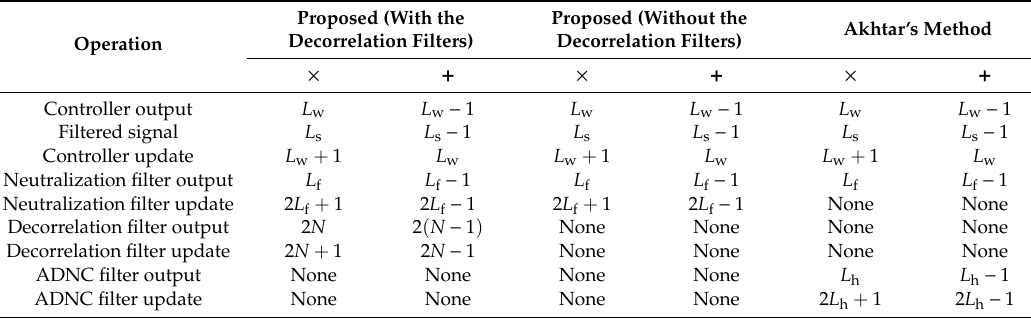
Table 1. Computational load for di ff erent